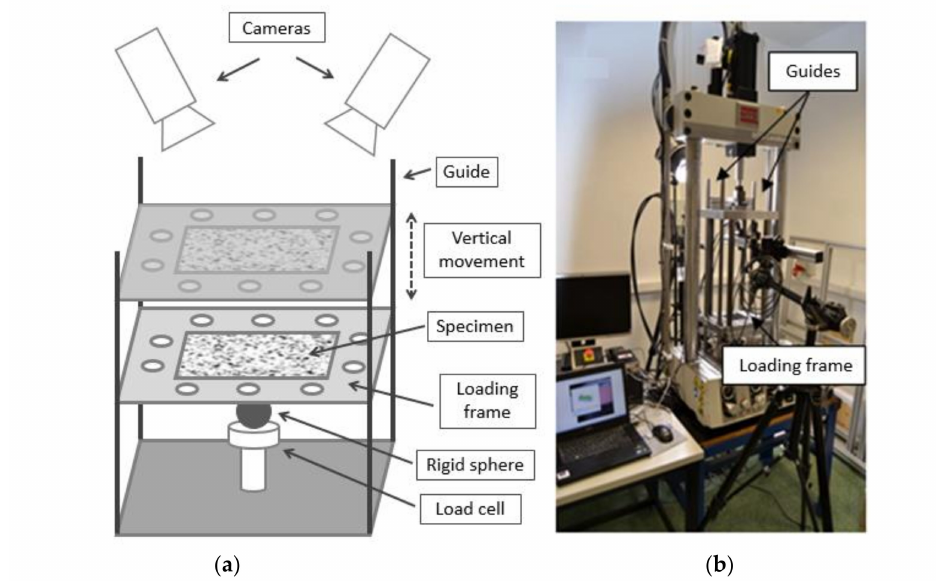
Figure 1. ( a ) Schematic of the setup to perform the experiments; ( b ) laboratory-adopted setup for the proposed experimen- tal